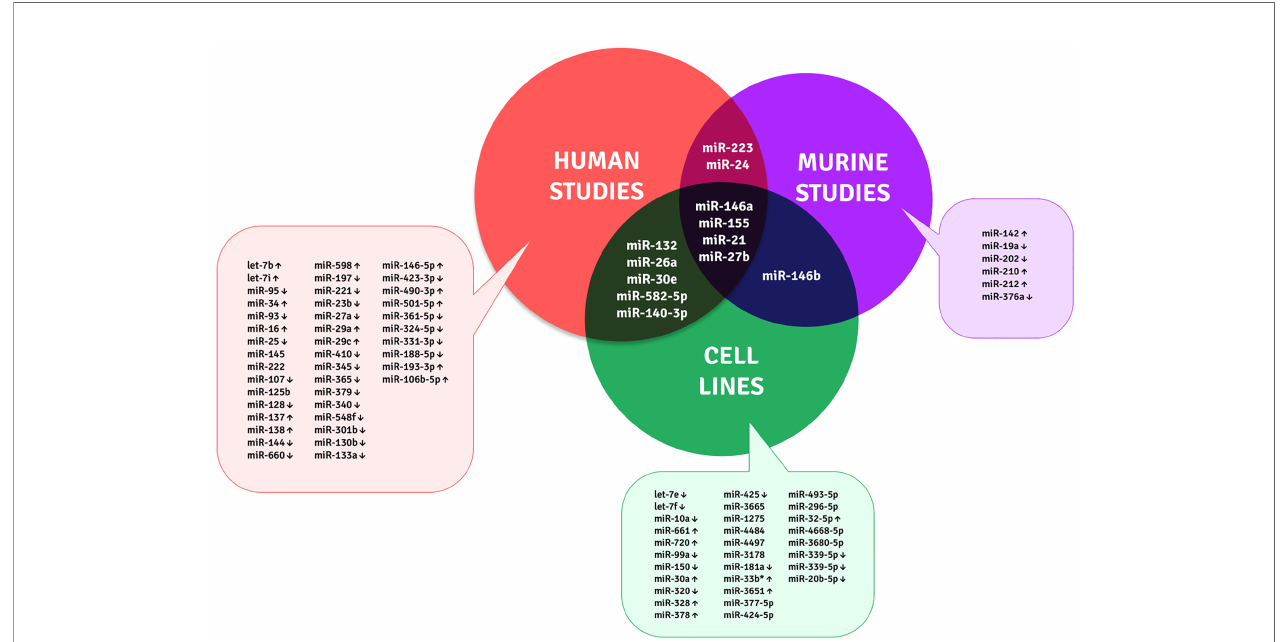
FIGURE 2 | Unique and shared miRNA biomarker candidates for TB within monocytes and macrophages across human, murine, and cell line